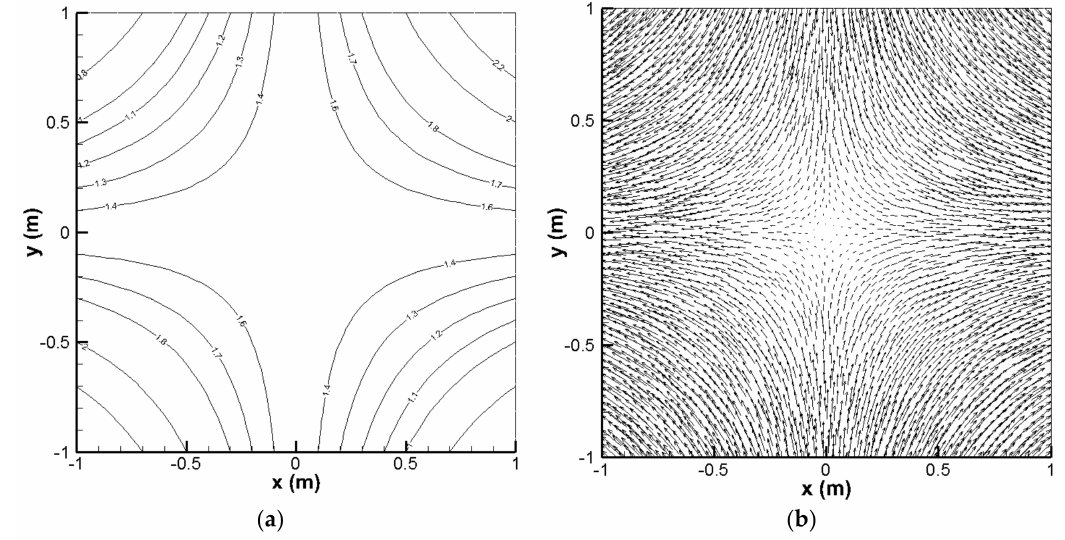
Figure 9. Numerical results of the potential flow test: ( a ) contours of water depth; ( b ) vector field of flow